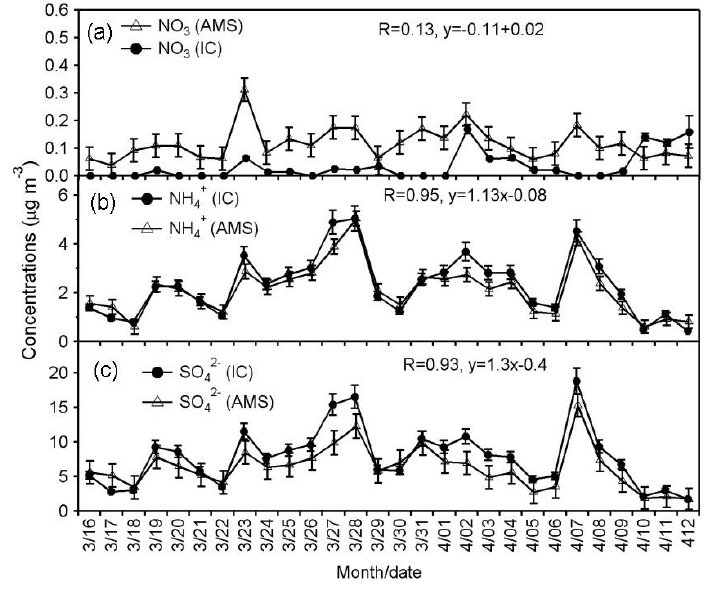
Figure 3. Temporal variations of ( a ) NO 3 − , ( b ) NH 4+ and ( c ) SO 42 − measured by two instruments (IC and AMS) in aerosols collected from Cape Hedo, Okinawa.